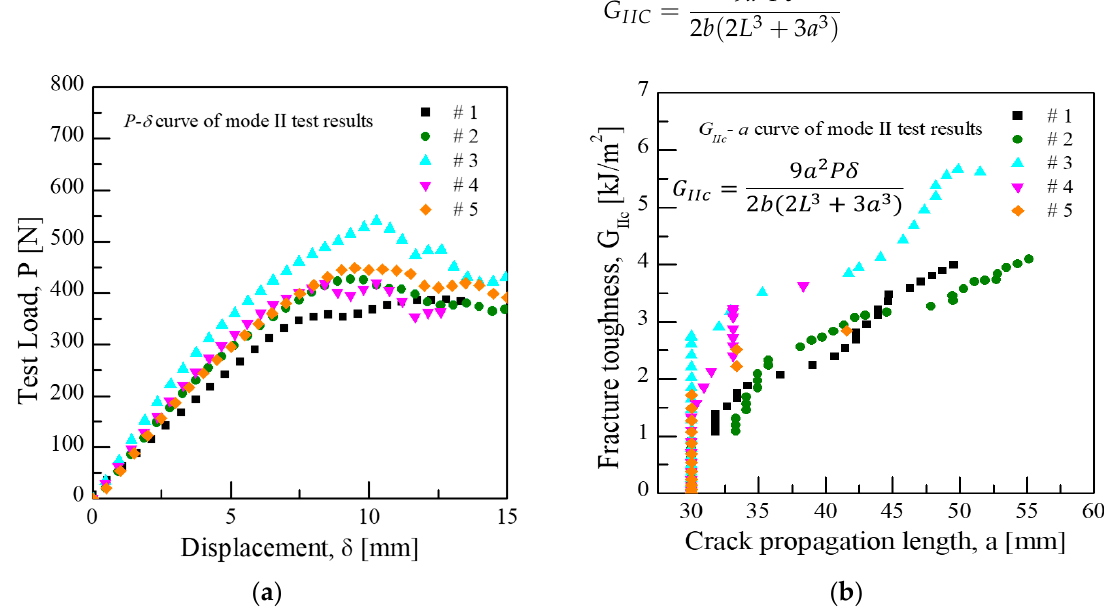
Figure 8. Mixed-mode fracture toughness test results: ( a ) 𝑃 − 𝛿 curve and ( b ) 𝐺 − 𝑎 curve. Figure 8. Fracture toughness test results of Mode II: ( a ) P − δ curve and ( b ) G − a